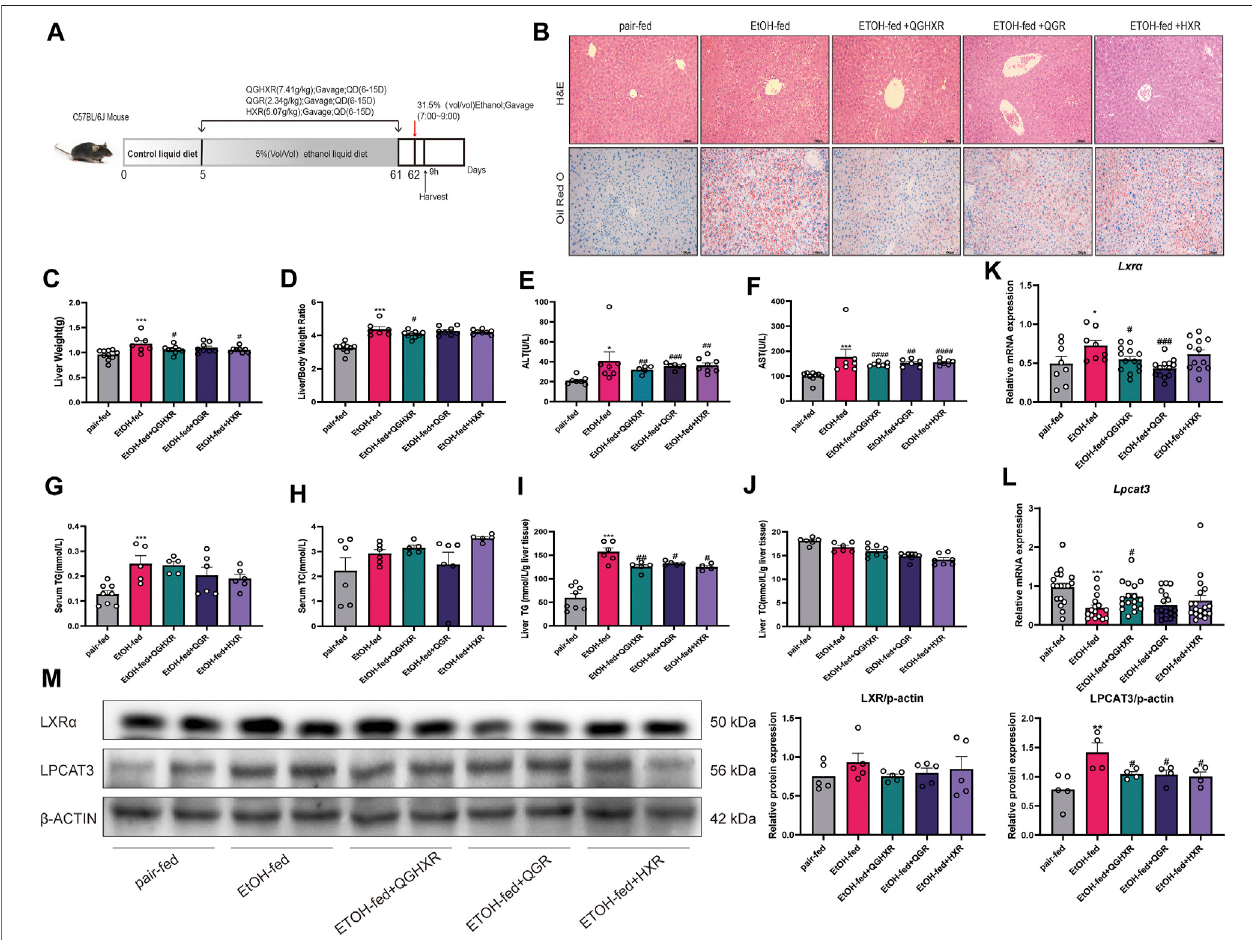
FIGURE1| ProtectiveeffectofQGHXRagainstalcohol-inducedliverinjuryinC57BL/6miceinvolvedmodulationofLXR α andLPCAT3. (A) Overviewofthealcohol- inducedliverinjurymousemodelprocedure. (B) RepresentativephotomicrographsoflivertissuewithH&EandoilredOstaining(×400,100 μ m). (C) Liverweight(g). (D) Liver/body weight ratio. (E) Serum level of alanine transaminase (ALT) (U/L). (F) Serum level of aspartate transaminase (AST) (U/L). (G) Serum level of cytoplasmic triglyceride (TG) (mmol/L). (H) Serum level of total cholesterol (TC) (mmol/L). (I) Liver level of cytoplasmic TG (mmol/L/g liver tissue). (J) Liver level of TC (mmol/L/g liver tissue). (K) mRNA expression of Lxr in liver tissues. (L) mRNA expression of Lpcat3 in liver tissues. (M) The protein expression of LXR and LPCAT3 in liver tissues. Data were presented as means ± SEM. The pair-fed group; EtOH-fed: ethanol-fed group; EtOH-fed + QGHXR: Qinggan Huoxue Recipe group with ethanol-fed;EtOH- fed + QGR: Qinggan Recipe group with ethanol-fed;EtOH-fed +HXR: Huoxue Recipe groupwithethanol-fed.Quanti fi cation of mRNAand protein level expression was normalized to β -actin levels. Compared with the control group, * p < 0.05, ** p < 0.01, *** p < 0.001; Compared with the EtOH-fed group, # p < 0.05, ## p < 0.01, ### p <